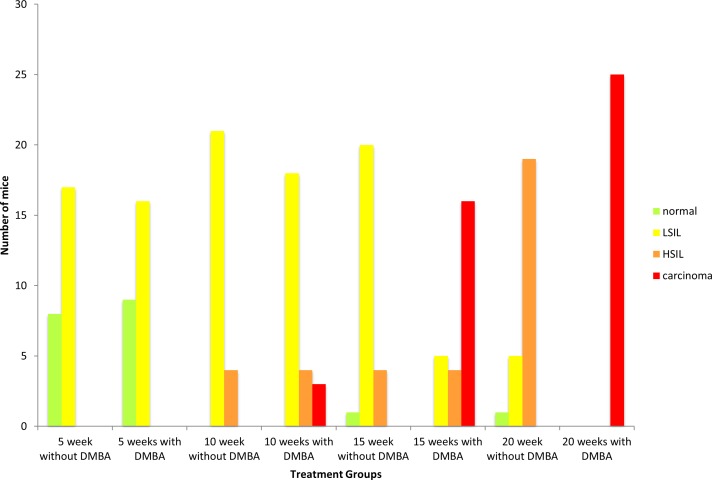
Histological analysis of the anal transition zone at various time points of DMBA treatment in K14E6/E7 mice.Anal histology identified by a trained pathologist for each time point (25 mice/group) following treatment with and without DMBA (0.12μmole topically to anus weekly). There is a statiscally significant increase in anal dysplasia over the time course of DMBA treatment, with the majority of the mice at 5 and 10 weeks of DMBA treatment having low-grade dysplasia, while 75% of mice at 15 weeks. By 20 weeks of DMBA treatment 100% of K14E6/E7 mice have overt carcinoma. During this same time course none of the K14E6/E7 mice not treated with DMBA developed anal cancer.